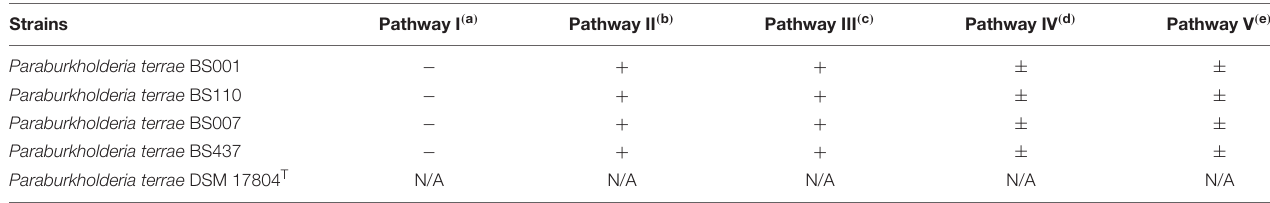
TABLE 2 | The list of oxalate degrading pathways according to MetaCyc. The potential presence ( + ) or absence ( − ) of oxalate degradation pathways is shown in the respective Paraburkholderia terrae strains. Cupin domain containing proteins are postulated to be acting either as oxalate oxidase or oxalate decarboxylase.